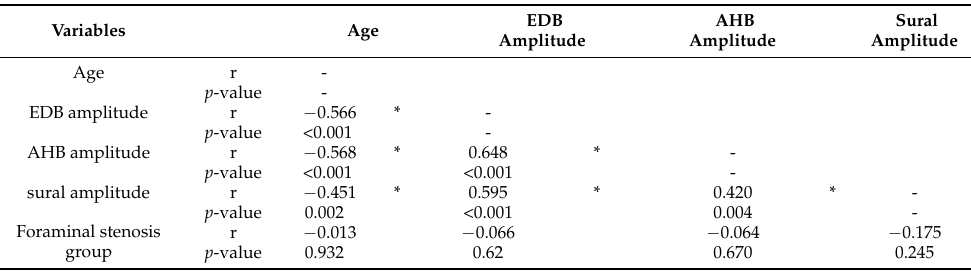
Figure 1. Between the two groups of foraminal stenosis, there is no significant difference in the EDB ( A ), AHB ( B ), and sural amplitude ( C ) and age ( D ). EDB: extensor digitorum brevis, AHB: abductor hallucis brevis. Table 3. Correlation matrix among age, severity of foraminal stenosis, and amplitude in the peripheral nerve conduction study.